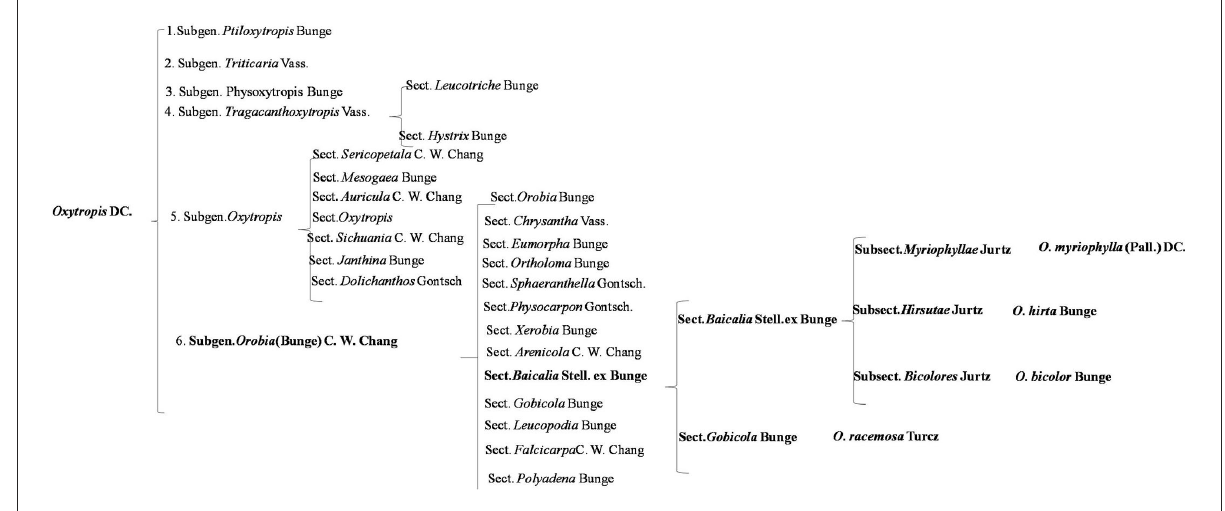
FIGURE11 Plant chemotaxonomy of the four Oxytropis